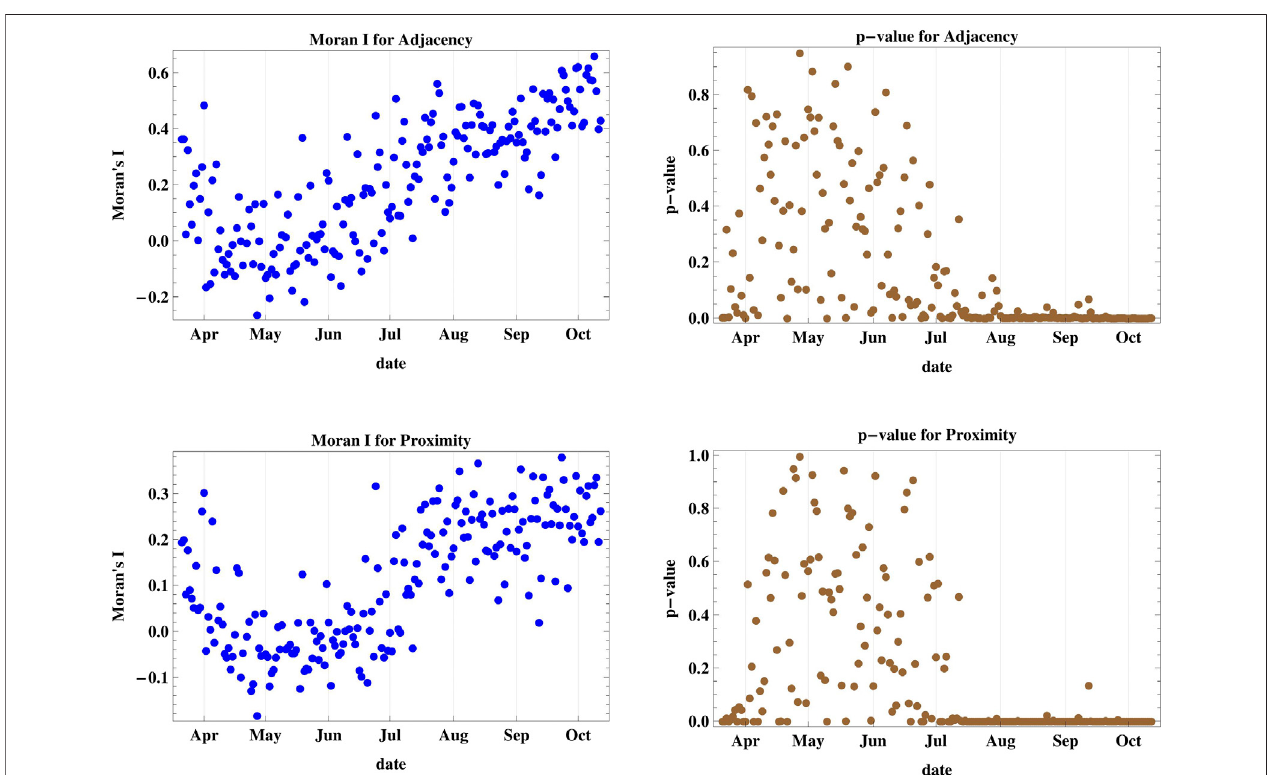
FIGURE2| The fi gureshowsMoran ’ s I indexanditscorresponding p -valueforcasesIandIIaccountingforadjacencyandproximityofnewinfectionsregisteredin Lebanese districts. Since July, there is a strong clustering of daily infections in regions sharing common borders and among nearer